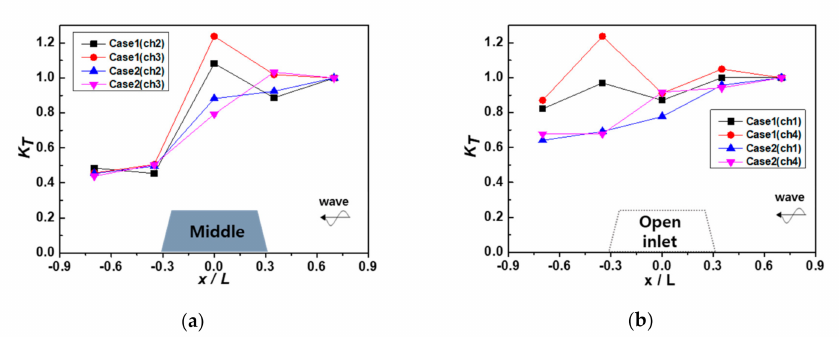
Figure 5. Wave transmission rates by structure type (Case 1: dolos; Case 2: hybrid (dolos with the coral reef)): ( a ) wave distribution around the structure and ( b ) wave distribution at the open